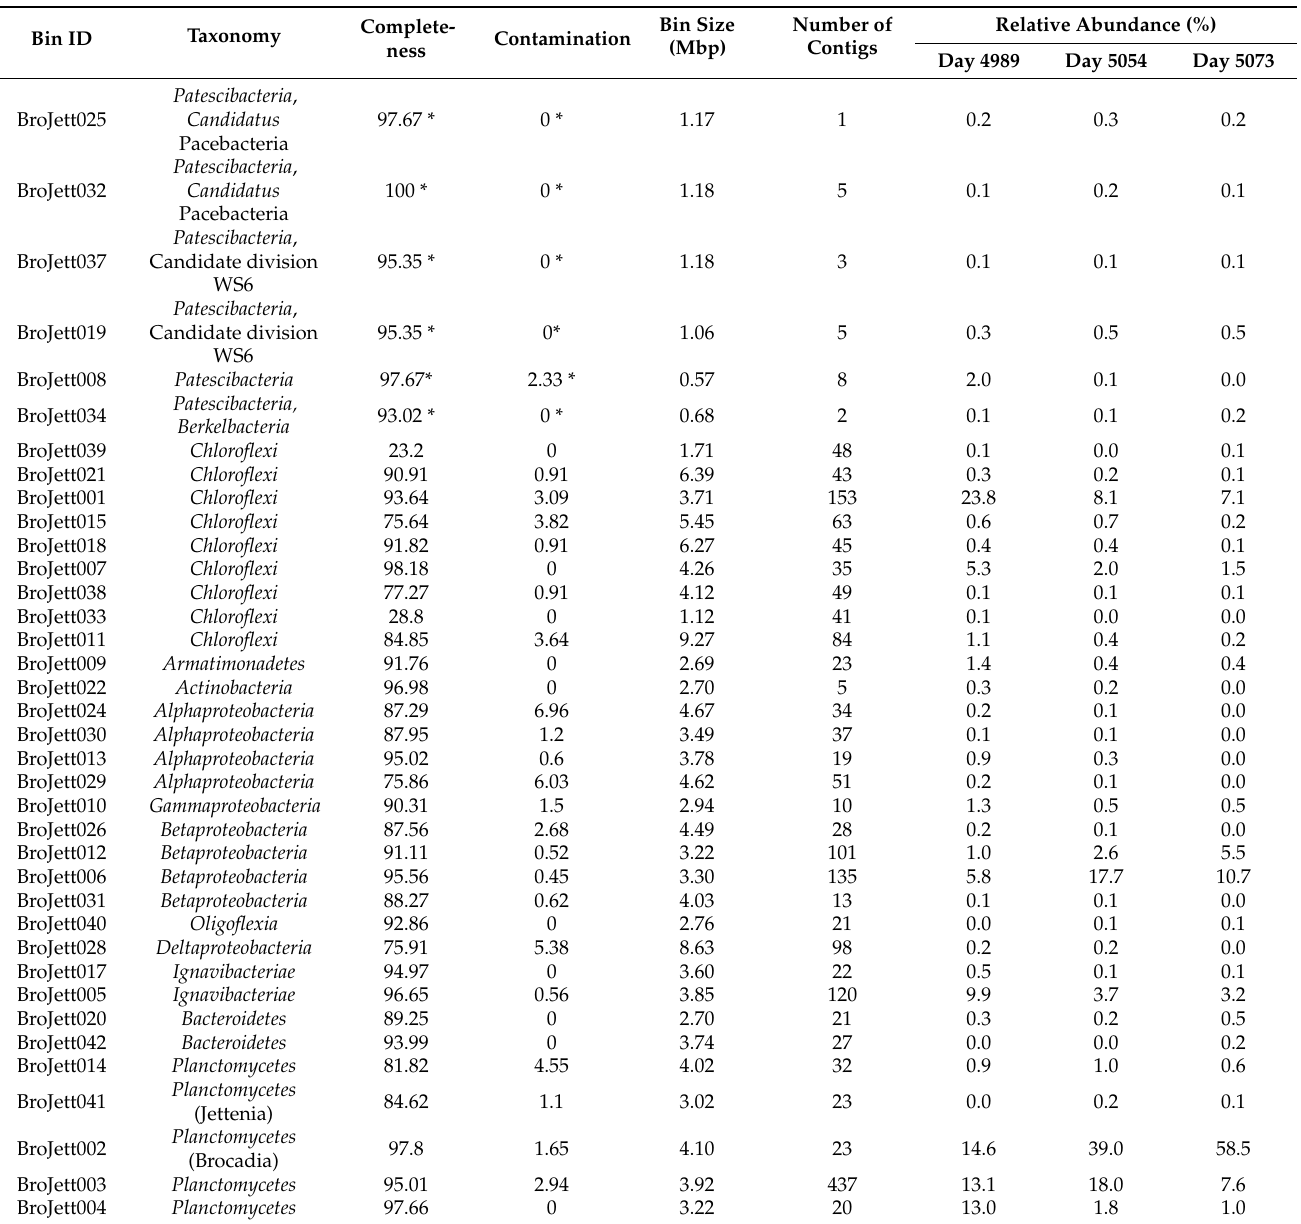
Table 1. Characteristics of the bins obtained in this